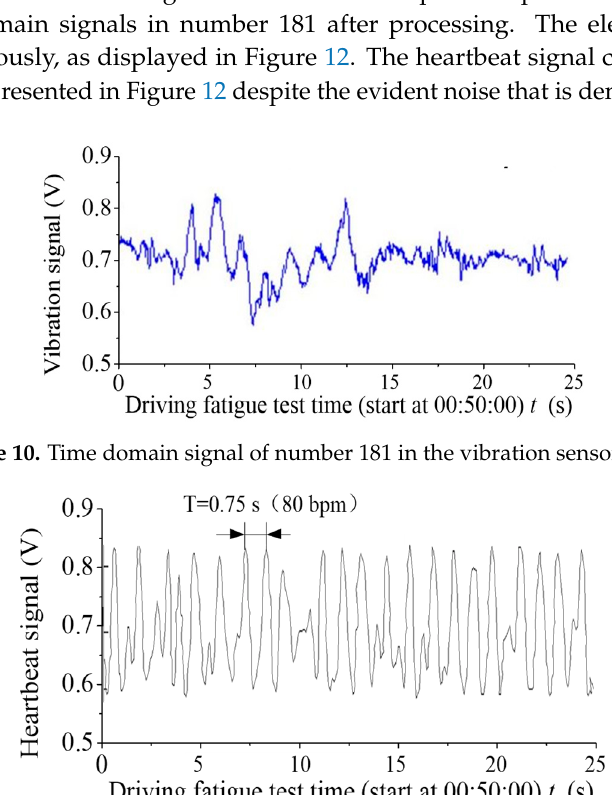
Figure 11. Extracted heartbeat signals of number 181 by noise reduction.